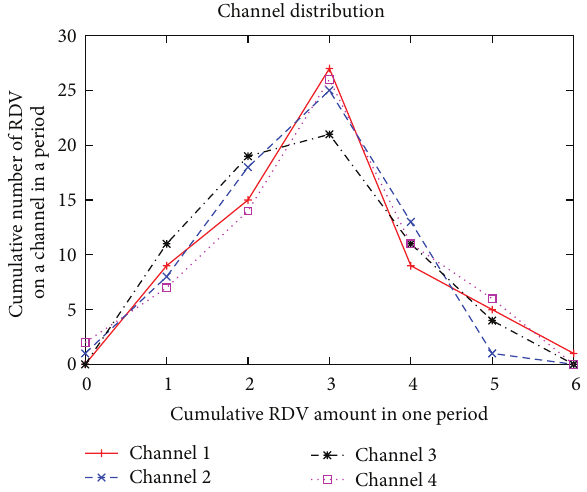
Figure 12: Common channel set: Map 7 Chs (91 slots).